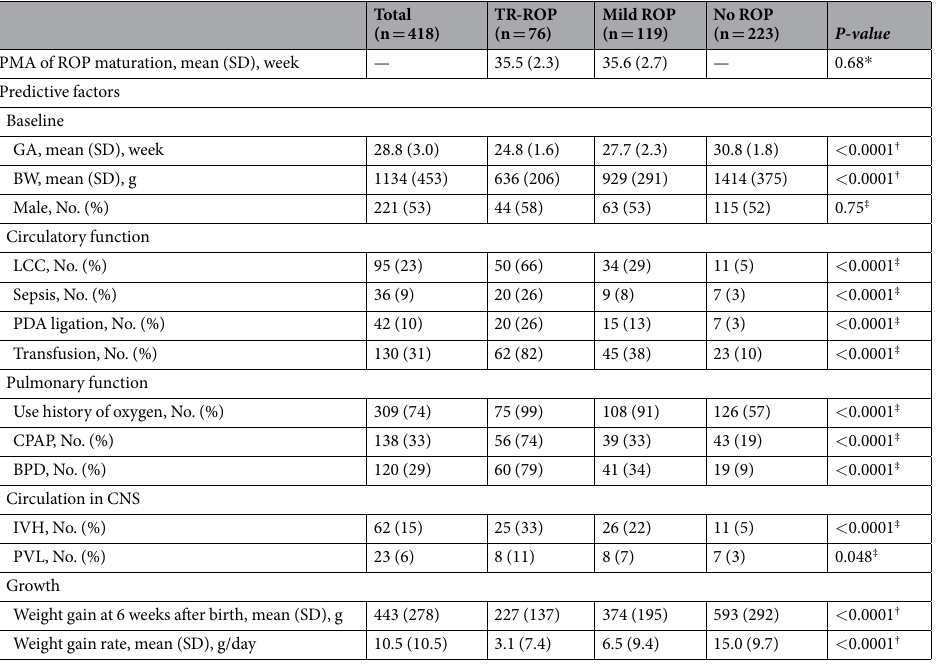
Table 2. Characteristics of the infants examined in this study. Abbreviations: ROP, retinopathy of prematurity; TR-ROP, treatment-requiring retinopathy of prematurity; PMA, postmenstrual age; GA, gestational age; SD, standard deviation; BW, birthweight; LCC, late-onset circulatory collapse; PDA, patent ductus arteriosus; CPAP, continuous positive airway pressure; PMA, postmenstrual age; BPD, bronchopulmonary dysplasia; CNS,